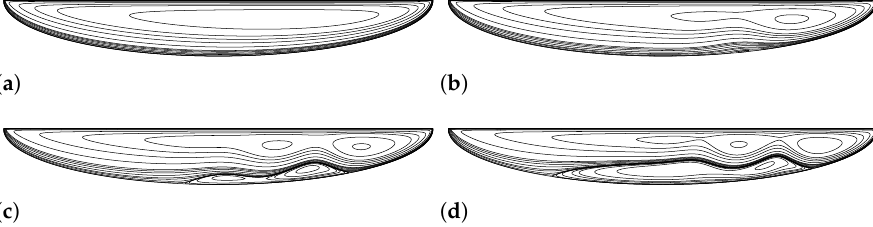
Figure 9. The evolution of the 1st solution of driven semi-elliptical cavity flow until Re = 7000 for D = 0.26 aspect ratio. ( a ) Re = 1000 (1st solution). ( b ) Re = 3000 (1st solution). ( c ) Re = 5000 (1st solution). ( d ) Re = 7000 (1st solution).